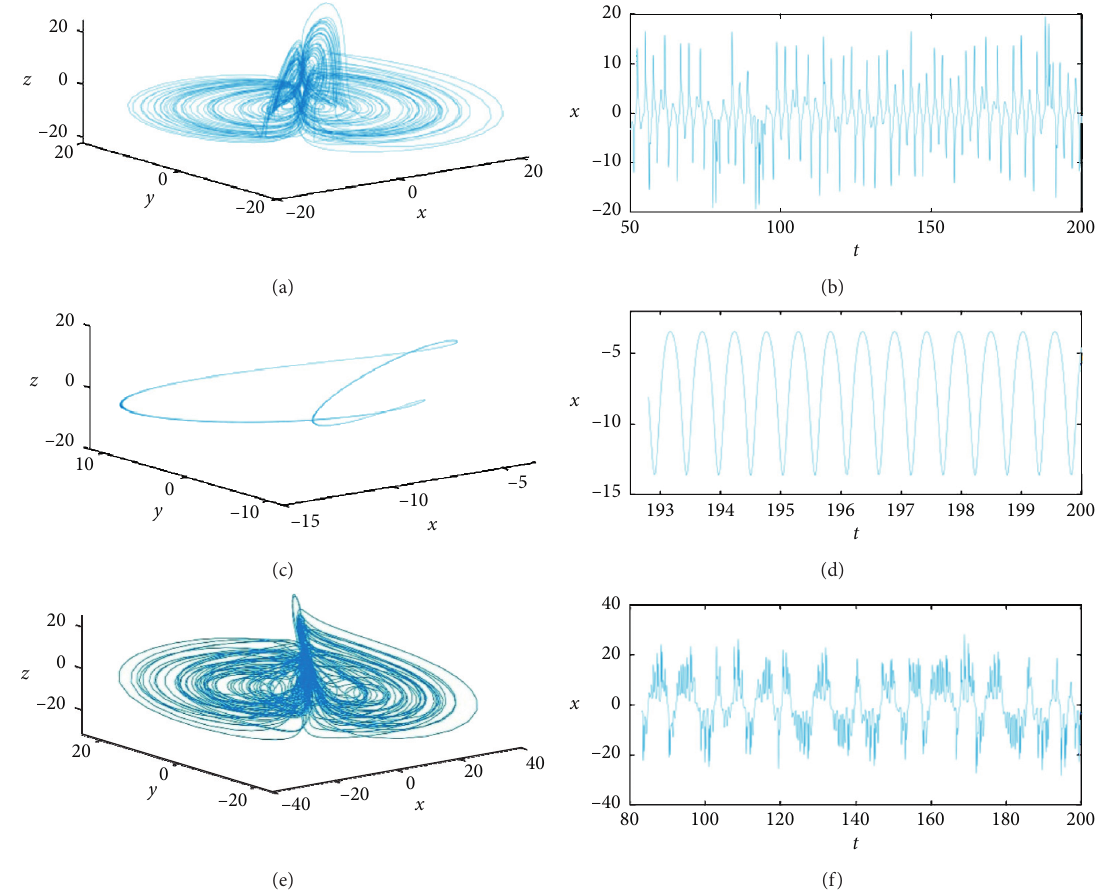
Figure 8: System phase diagram and time history diagram for different values of time-lag regulation strength f. (a) Phase diagram of the system at f � 2. (b) Time course diagram at f � 2. (c) Phase diagram of the system at f � 2.5. (d) Time course diagram at f � 2.5. (e) Phase diagram of the system at f � 4. (f) Time history diagram at f �